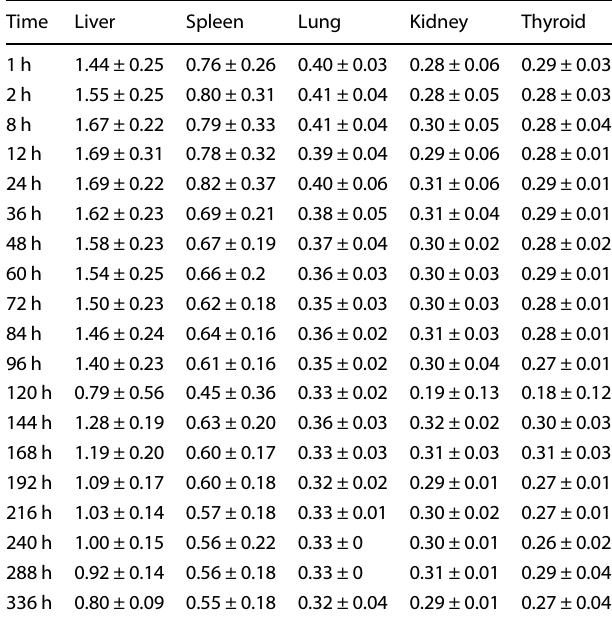
Table 3. The ratio of tissue to cardiac blood pool (T/C) for 131 I- meplazumab (mean ±